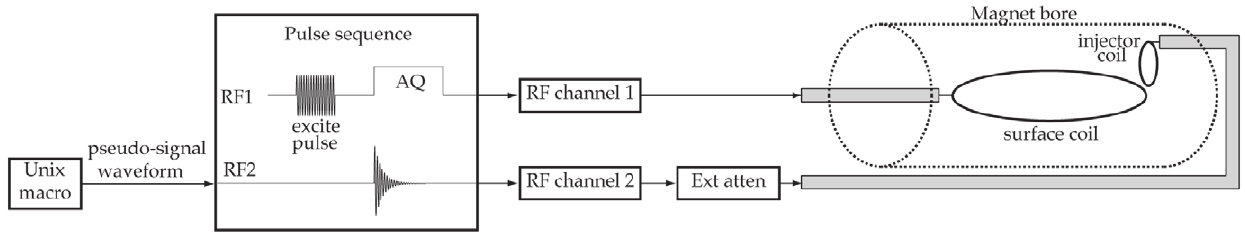
Figure 1. The key hardware components required to inject the pseudo-signal. Prior to execution of the pulse sequence, a Unix macro was used to create a digitized waveform describing the desired pseudo-signal. The pulse sequence read the waveform and sent it to the second RF channel (RF2). The pseudo-signal passed through an external attenuator (Ext atten) before being fed to the injector coil. During sequence execution, the surface coil was operated in transmit/receive mode while the injector coil was used only to transmit the pseudo-signal during the acquisition window (AQ).